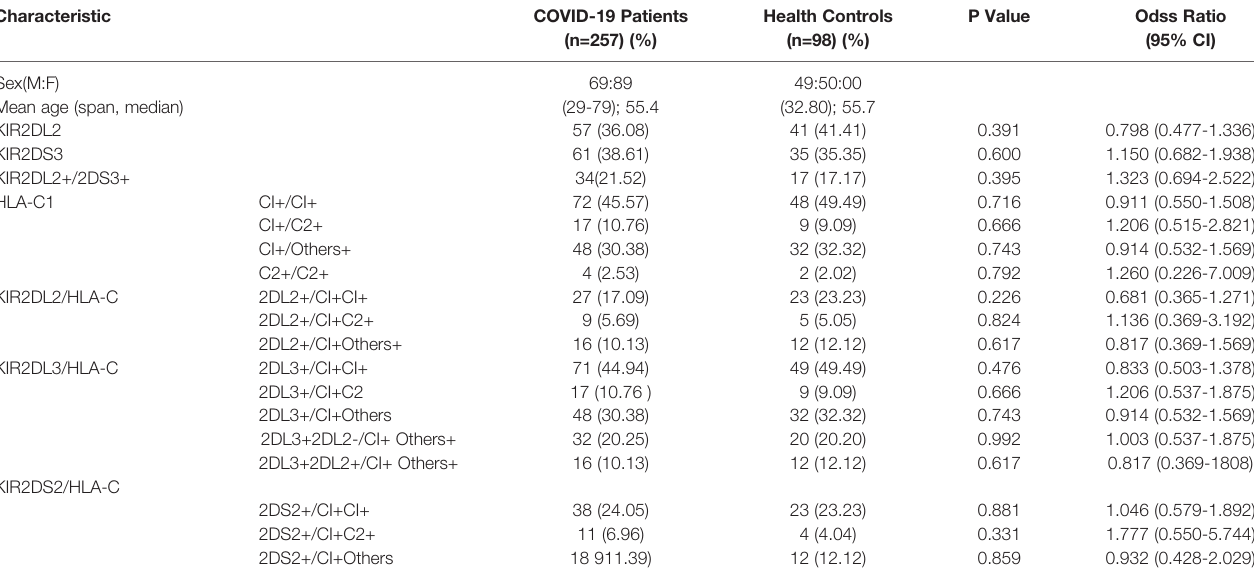
TABLE 3 | Correlation analysis of KIR/HLA-C between mild and severe COVID-19 patients. Characteristic COVID-19